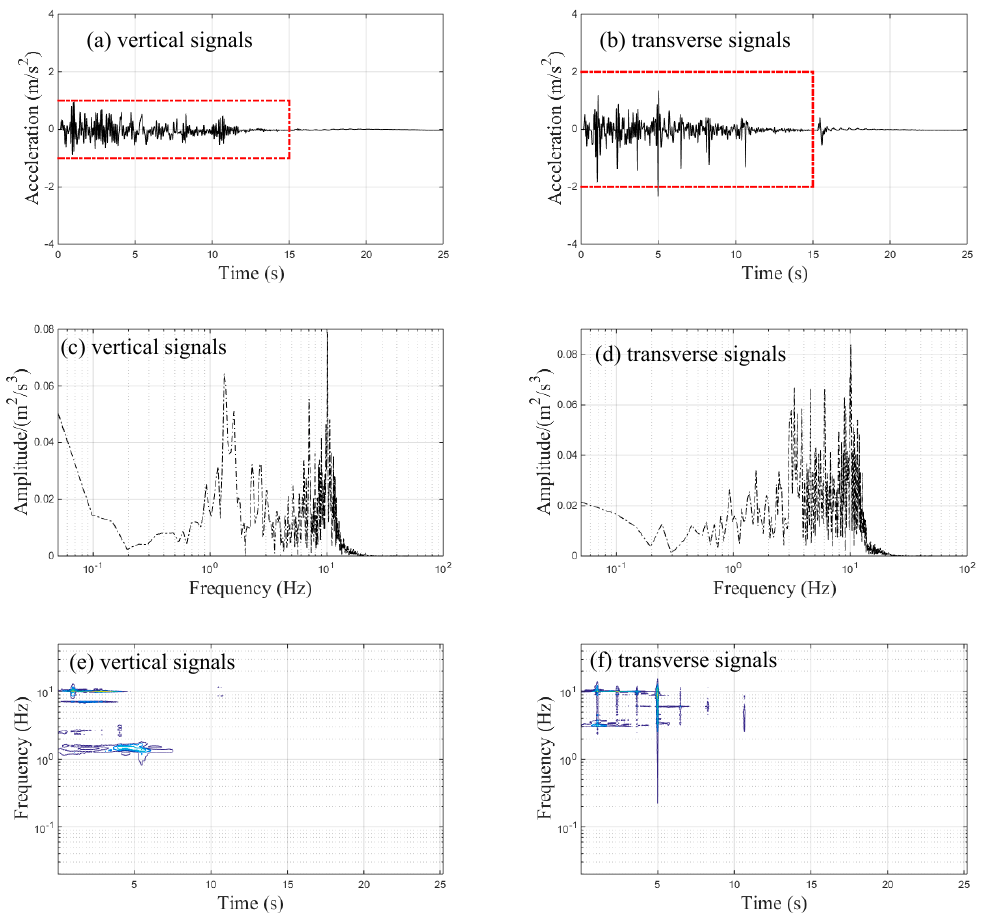
Figure 9. Acceleration signals of the bogie frame during braking: ( a ) time-history data of vertical signals; ( b ) time-history data of transverse signals; ( c ) FFT results of vertical signals; ( d ) FFT results of transverse signals; ( e ) TFRs of vertical signals; ( f ) TFRs of transverse signals.